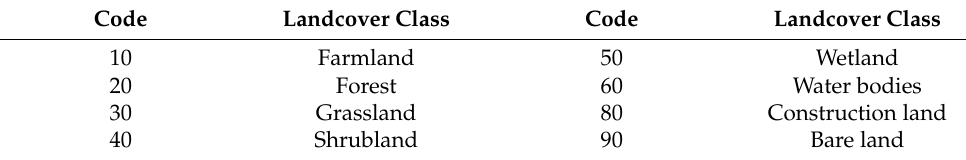
Table 1. Land use/cover classification system transformation. Code Landcover Class Code Landcover Class 10 Farmland 50 Wetland Forest Grassland 80 Construction land 40 Shrubland 90 Bare